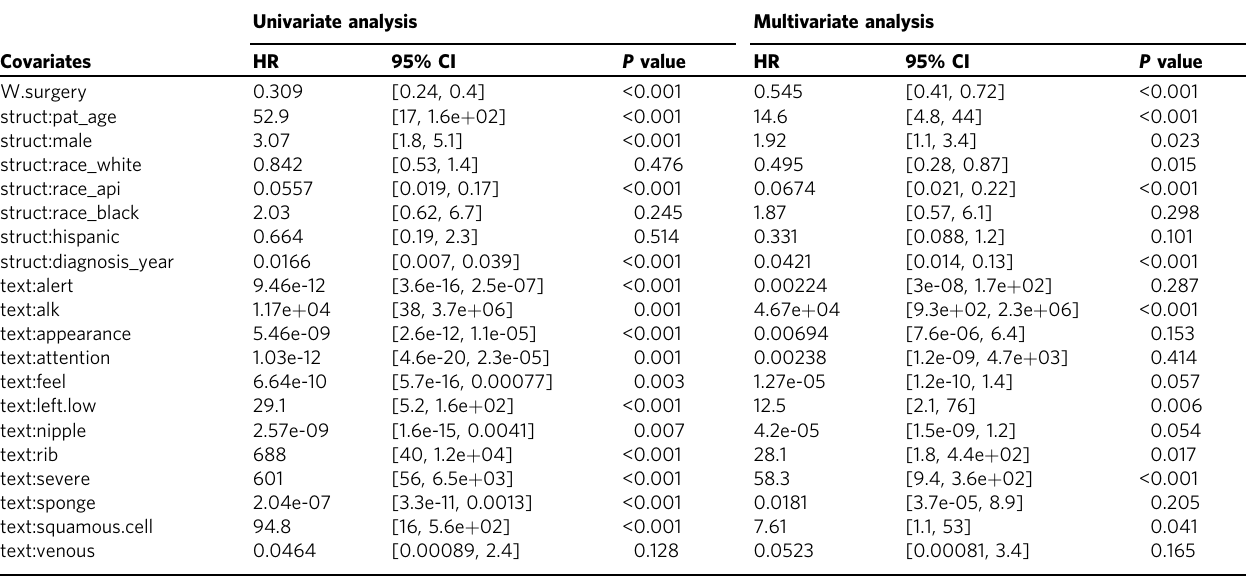
Table 6 Univariate and multivariate covariate-speci fi c HR for surgery vs. radiation for stage I NSCLC. Univariate analysis Multivariate